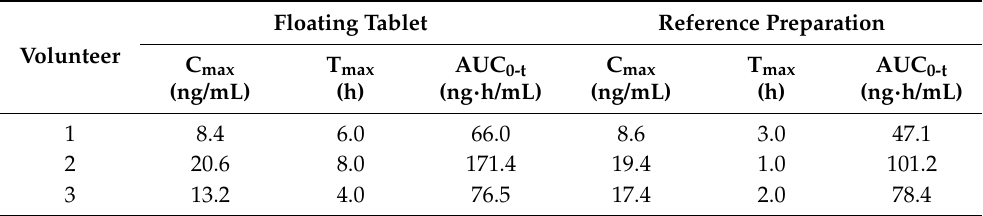
Figure 4. Mean plasma concentration versus time profiles of thiamine after administration of the floating tablet and reference preparation under the fed condition ( n = 8, mean ± SEM). Table 4. Individual numerical values of C max , T max , and AUC 0-t , and 90% confidence interval for thiamine after administration of the floating tablet and reference preparation in the fed state.